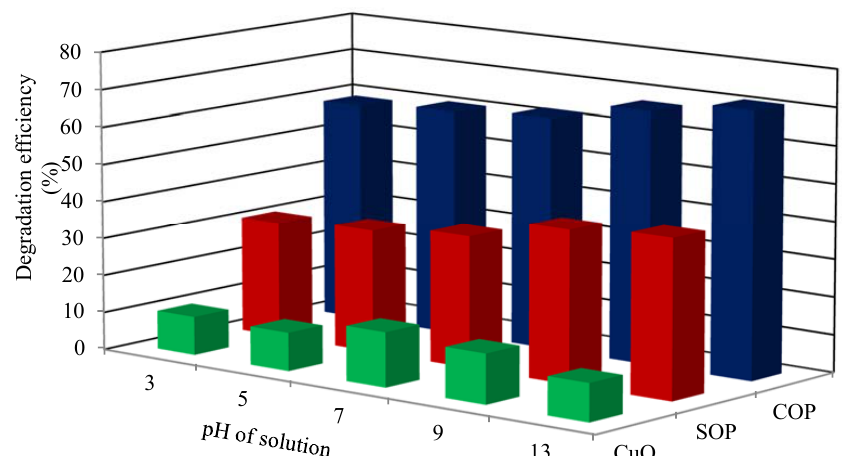
Fig. 2: The effect of pH on benzene removal efficiency